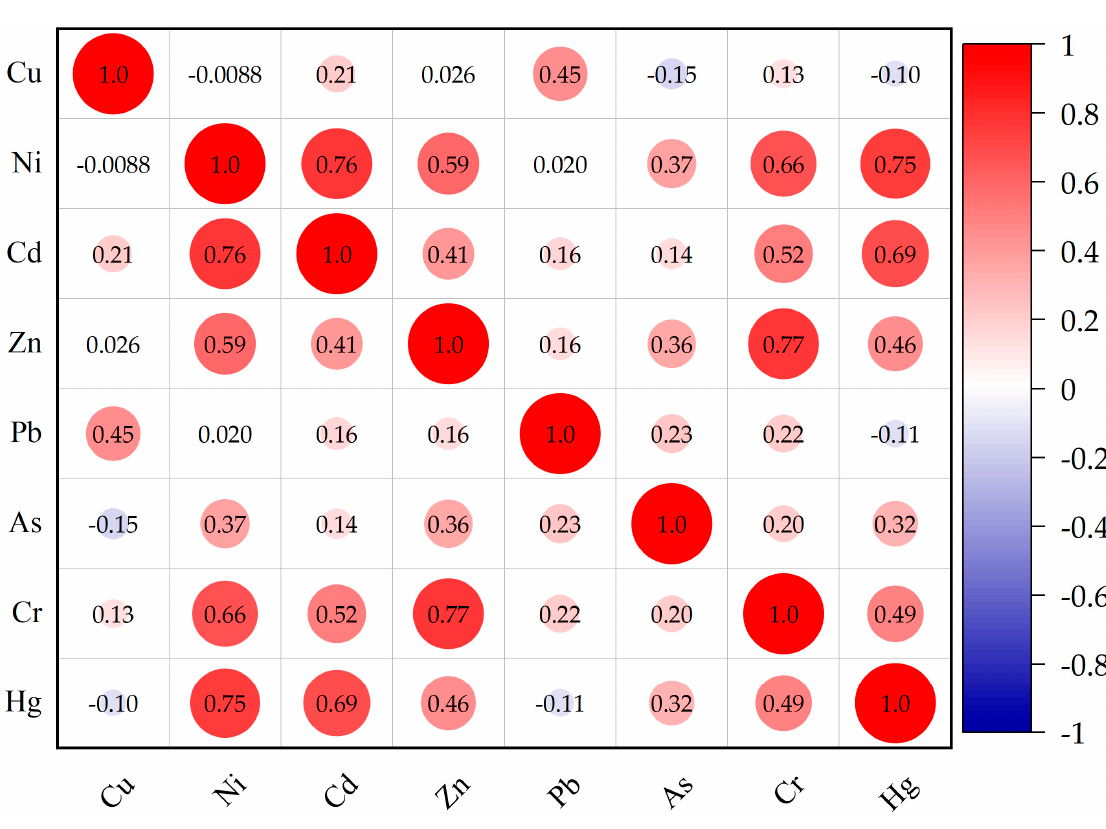
Figure 3. Sludge heavy metal Pearson correlation